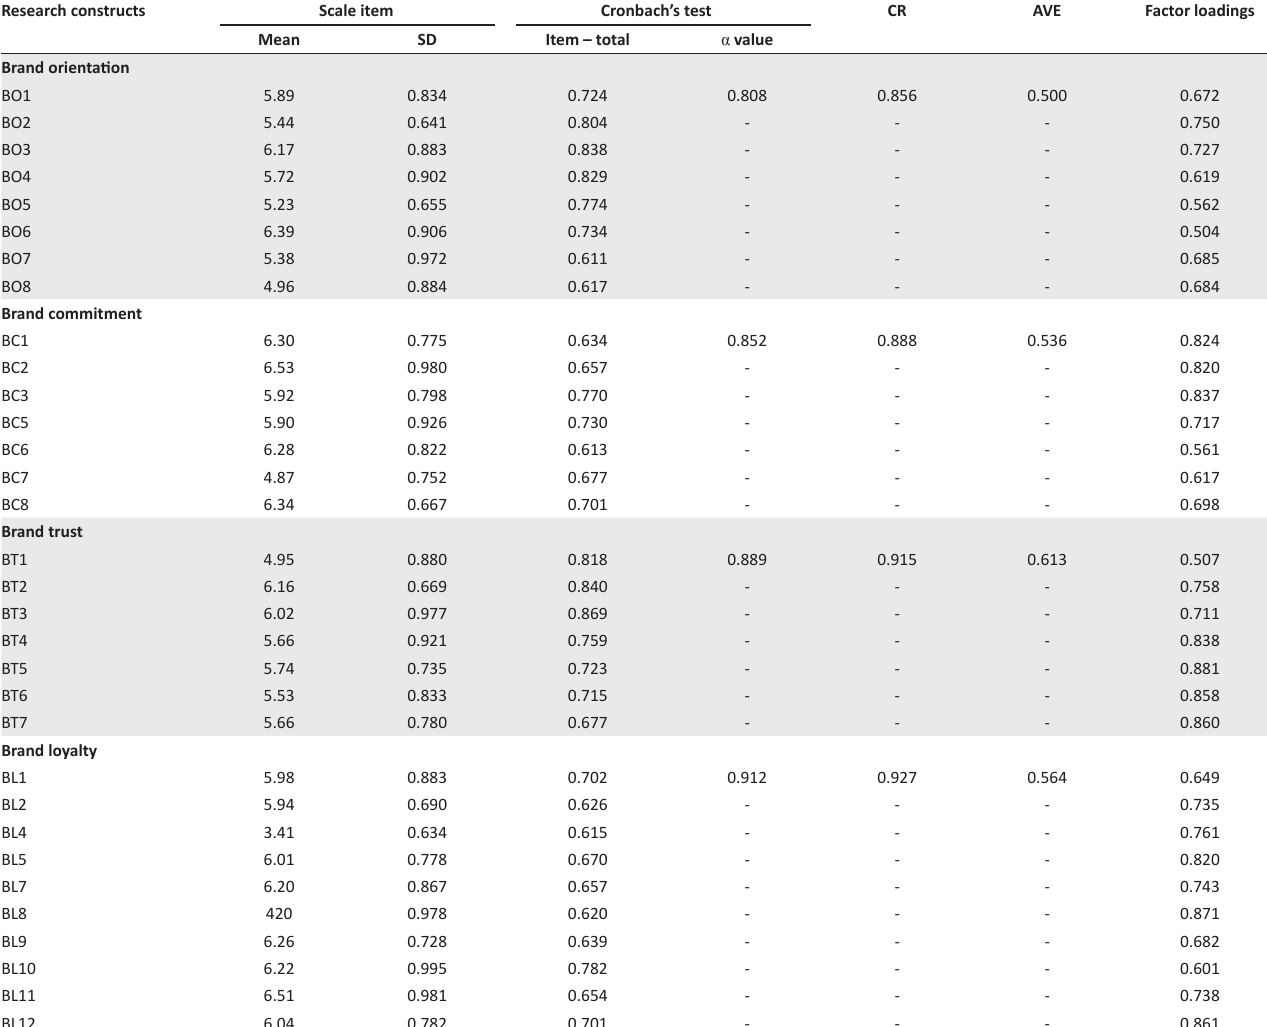
TABLE 2: Measurement accuracy statistics. Research constructs